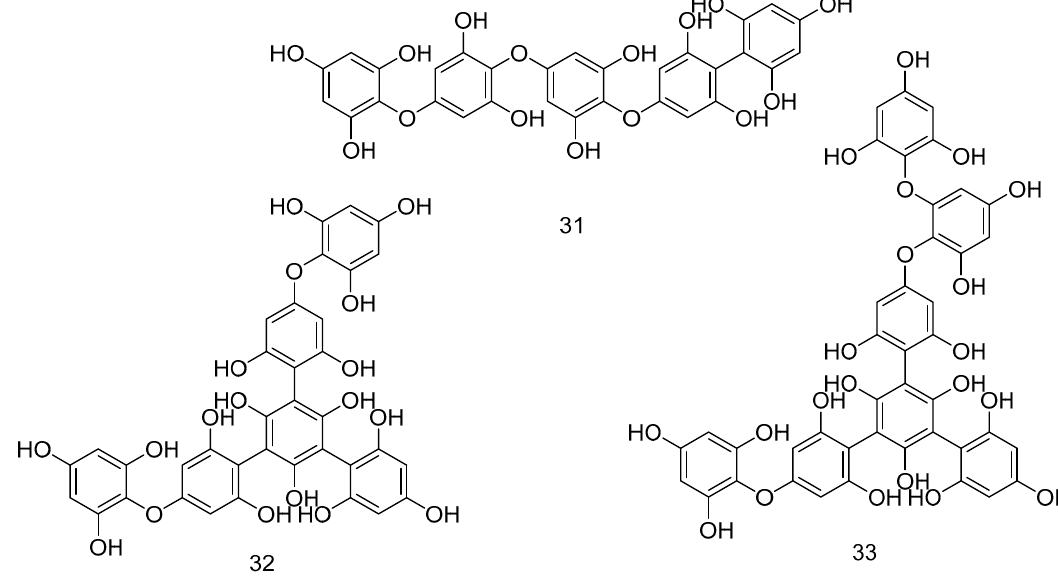
Figure 9. Compounds from 31 – 33 (Polyphenolic